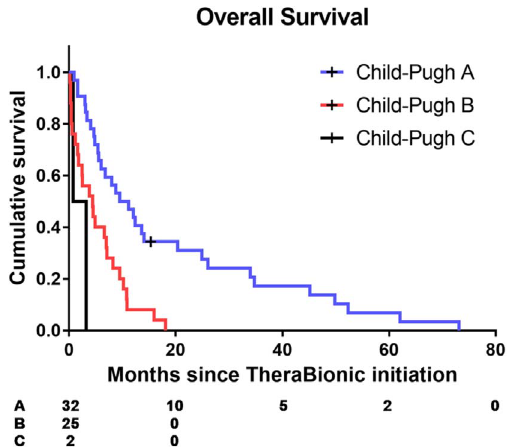
Figure 1. Survival curves of patients receiving treatment with the TheraBionic device. OS of 59 patients treated with the TheraBionic device strati fi ed by Child-Pugh status